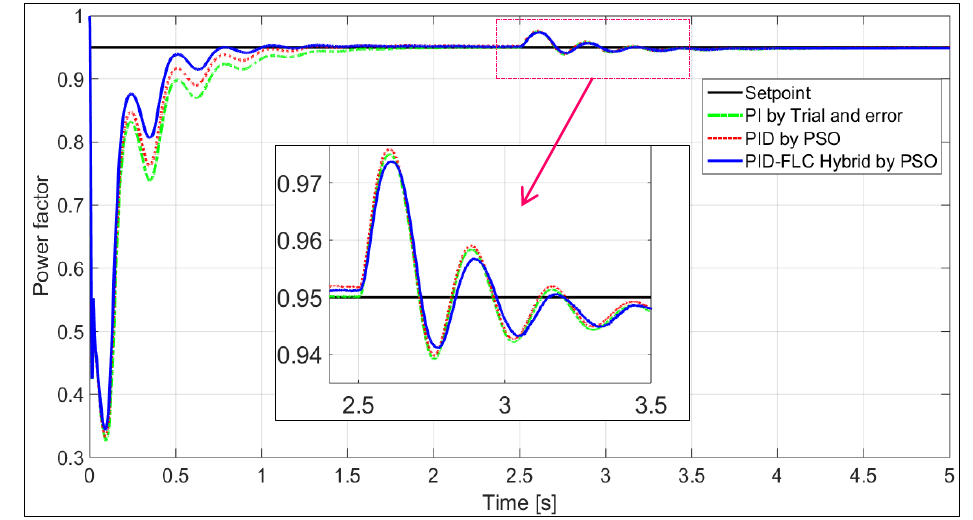
Figure 16. Response of cos  when cos  _ref is increased from 0.85 to